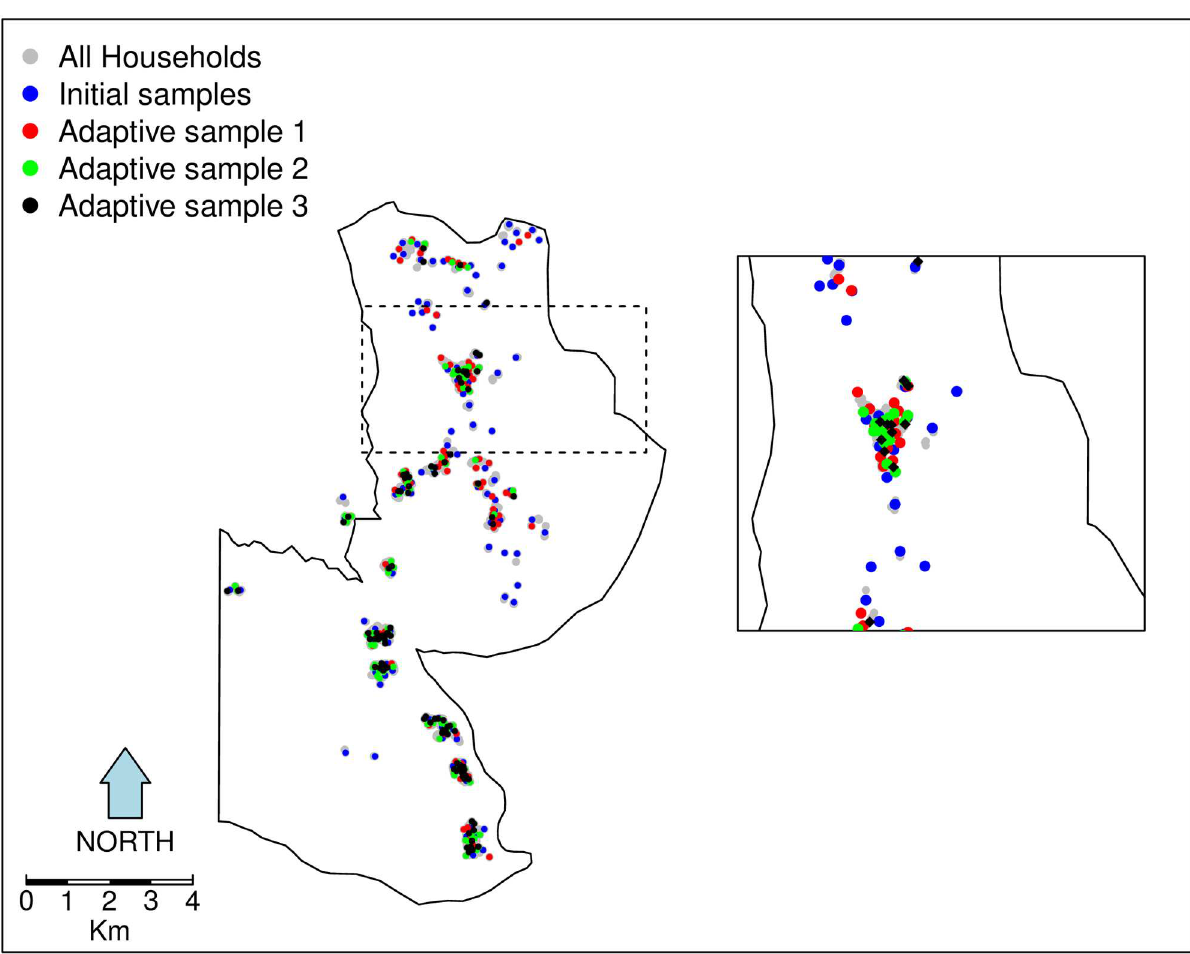
Fig 2. Adaptive sampling in practice, initial spatially inhibitory design samples augmented with adaptive design samples. The map illustrates adaptivesamplingin practice. All households in the study area are shown as grey dots. Results from the initial inhibitory random samples households (blue dots) and subsequent samples were used to generatethe next adaptivesamples (red, green and black dots). Each subsequent sample, used accruingdata from previous sample results. Inset shows a zoomed-in subset of locations.